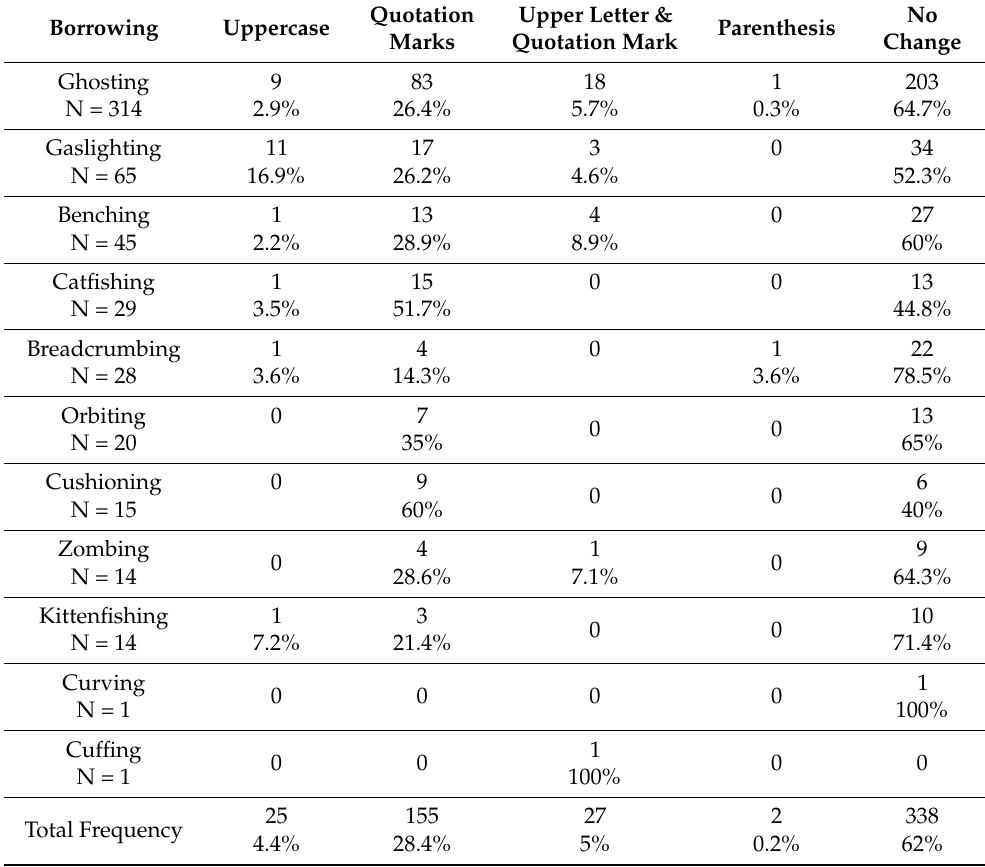
9 2.9% 11 16.9% 1 2.2% 1 3.5% 1 3.6% 0 7 0 9 0 1 7.2% 0 0 0 0 0 0 25 4.4%